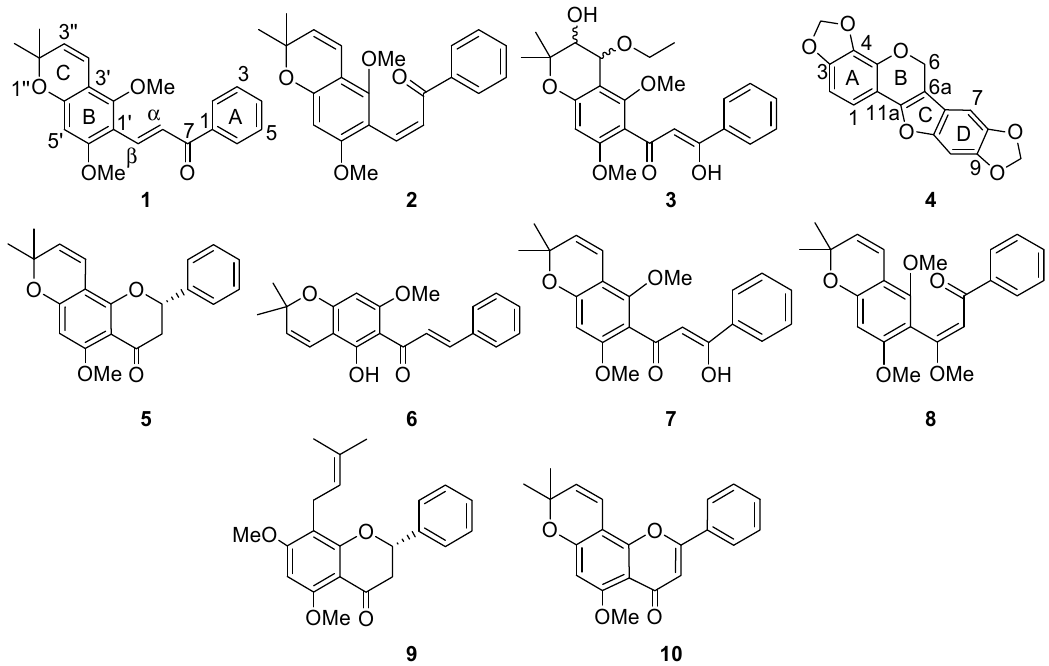
Figure 1. Compounds 1 – 10 isolated from the roots of Tephrosia aequilata.